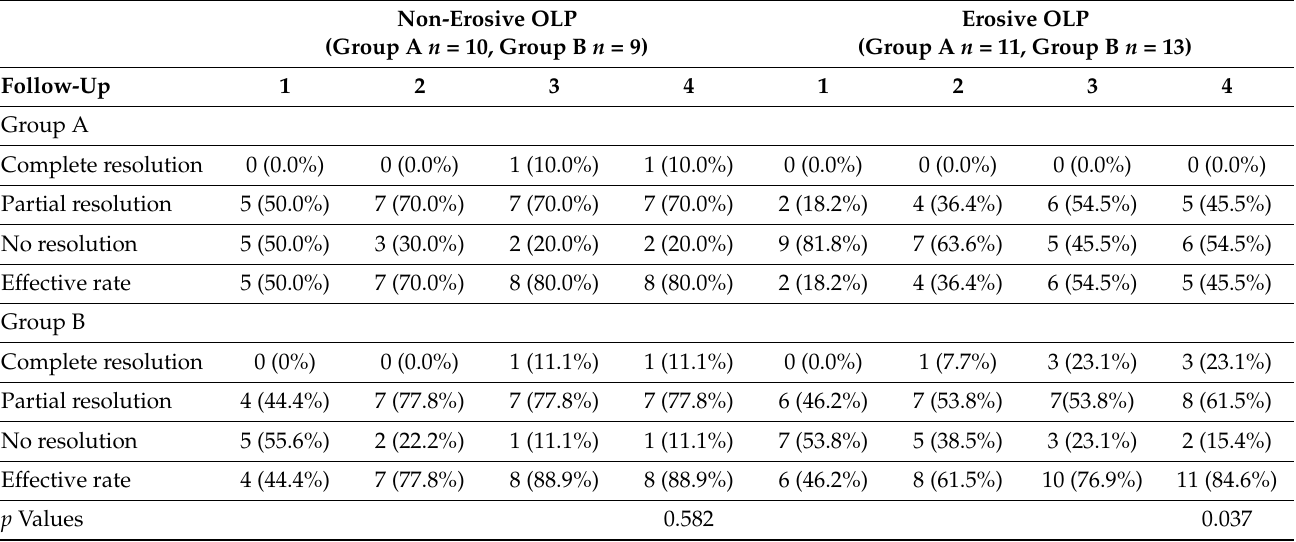
Figure 5. Sign score ( A ) and VAS ( B ) trends before and after treatment of patients with non-erosive OLP in Group A using dexamethasone plus gentamycin mouthwash and Group B by dexame- thasone plus gentamycin mouthwash combined with TGP capsules. * Compared with initial visit of the same group, * p < 0.05, ** p < 0.01 , ## compared with group A at the same month , # p < 0.05, ## p < 0.01.